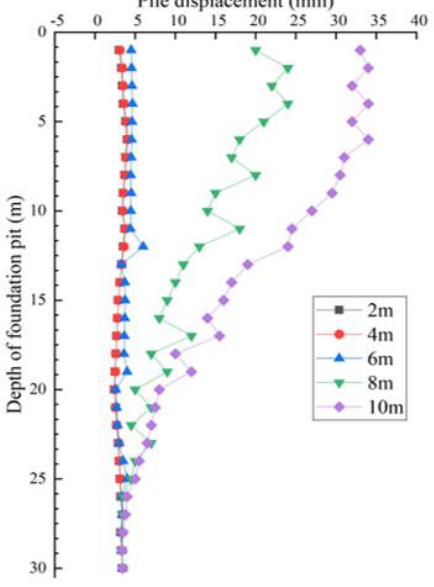
Figure 8. Horizontal displacement of rear straight pile.